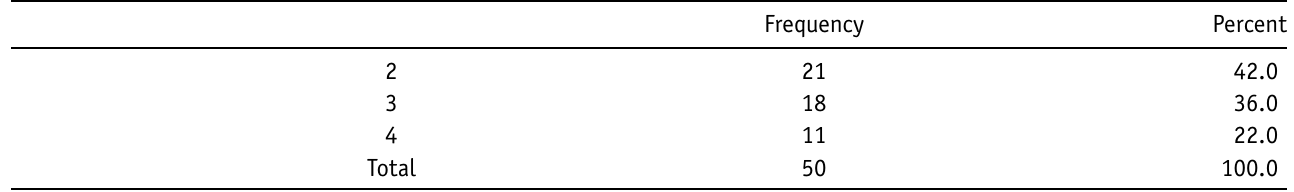
Table V. Distribution as per frequency of the habit per